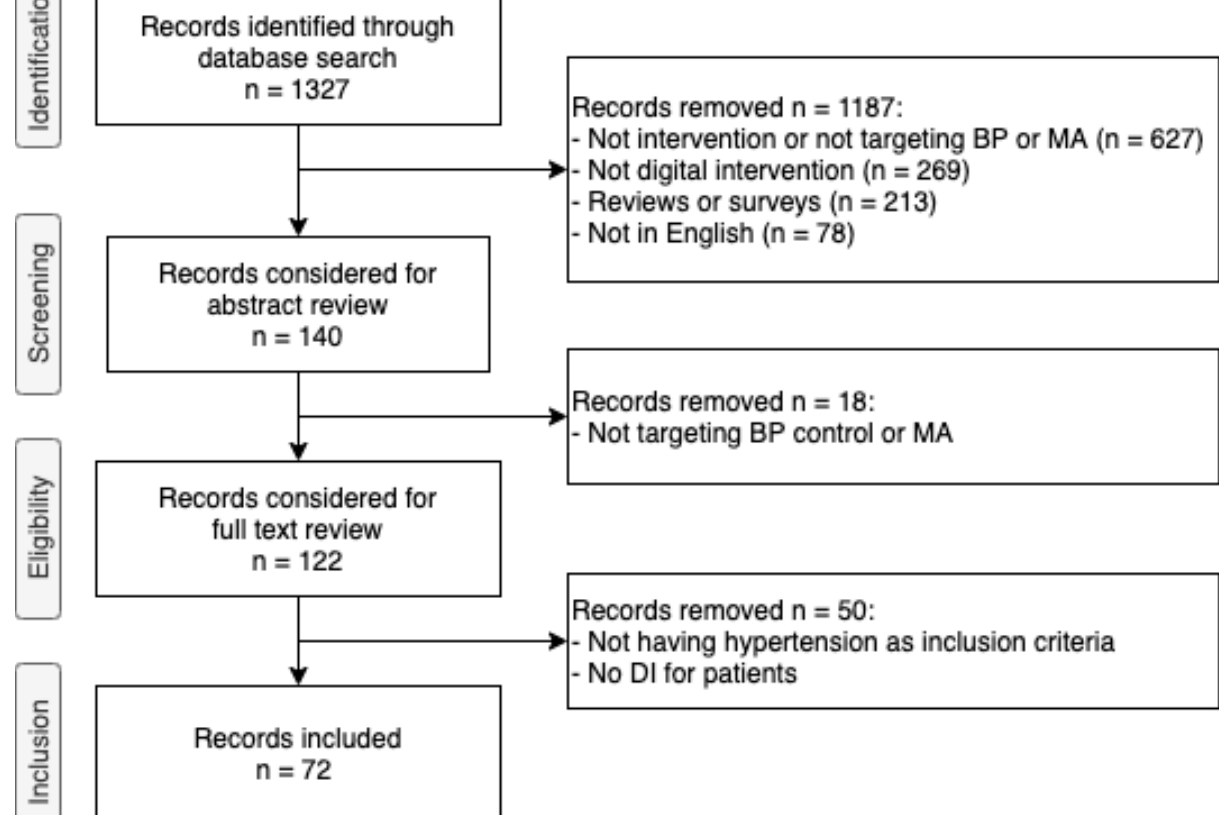
Figure 1. Flowchart of study inclusion. BP: blood pressure; MA: medication adherence; DI: digital